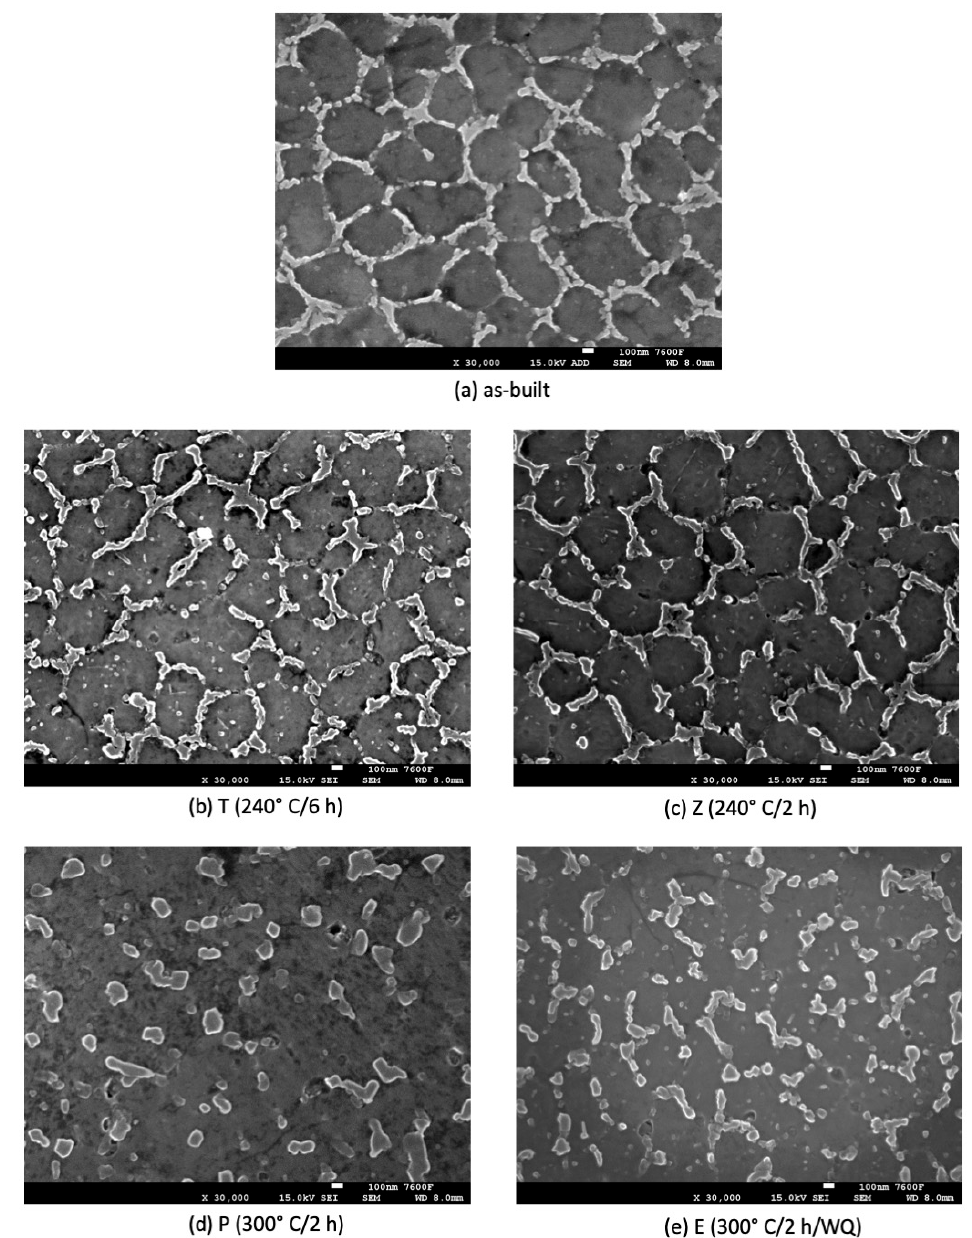
Figure 8. SEM analysis of the microstructure of ( a ) as-built and ( b – e ) stress relief annealed L-PBF AlSi10Mg samples in the transverse cross-sections, magnification 30 k.